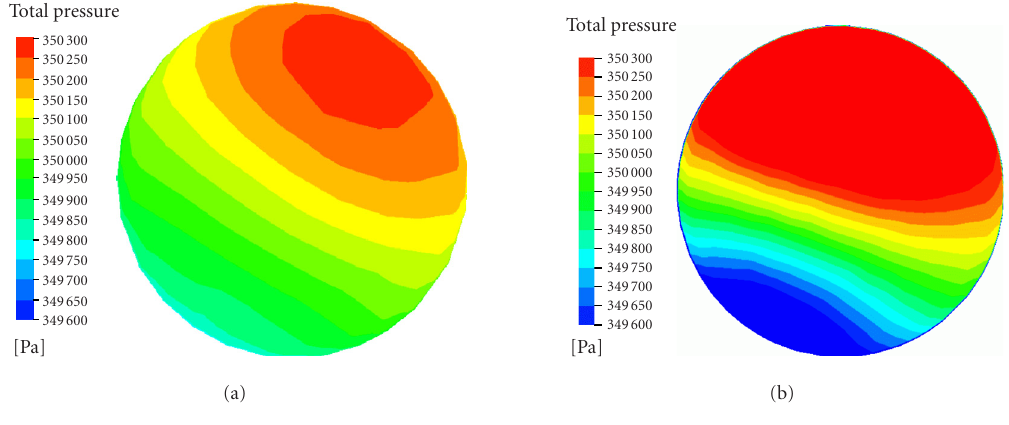
Figure 11: Total pressure contour at the discharge of exit cone. (a) Sharp tongue. (b) Round tongue, showing a much steeper pressure gradient, contributing to the secondary flow seen in Figure